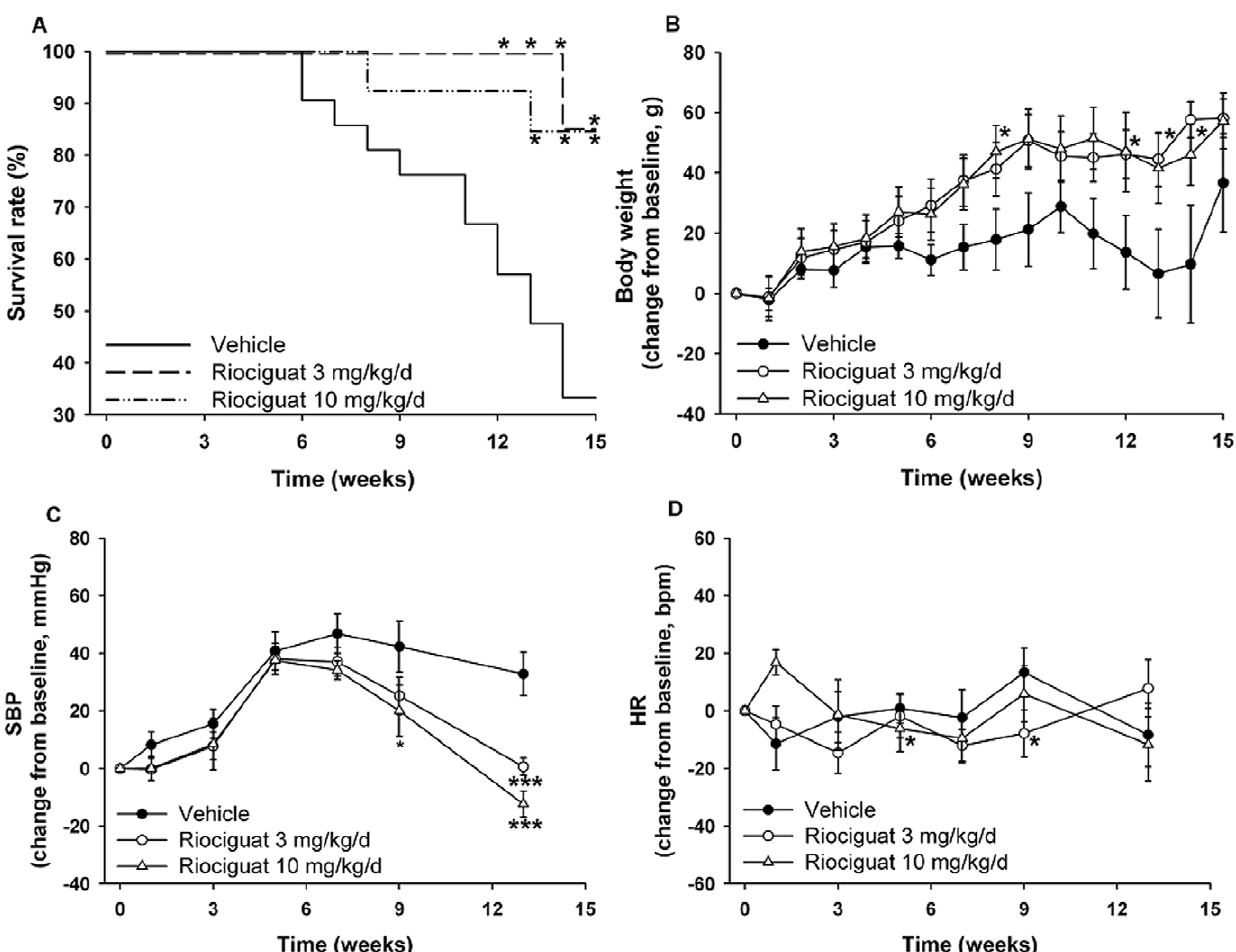
Figure 1. Effects of riociguat on survival (A), body weight (B), systolic blood pressure (C) and heart rate (D) in Dahl/ss rats maintained on a high-salt diet. Vehicle- (n=21) and riociguat-treated (3 or 10 mg/kg/d, n=13 per group) rats were observed for 14 weeks. Data are mean 6 SEM; *p , 0.05, ***p , 0.001 vs. the vehicle-treated animals.